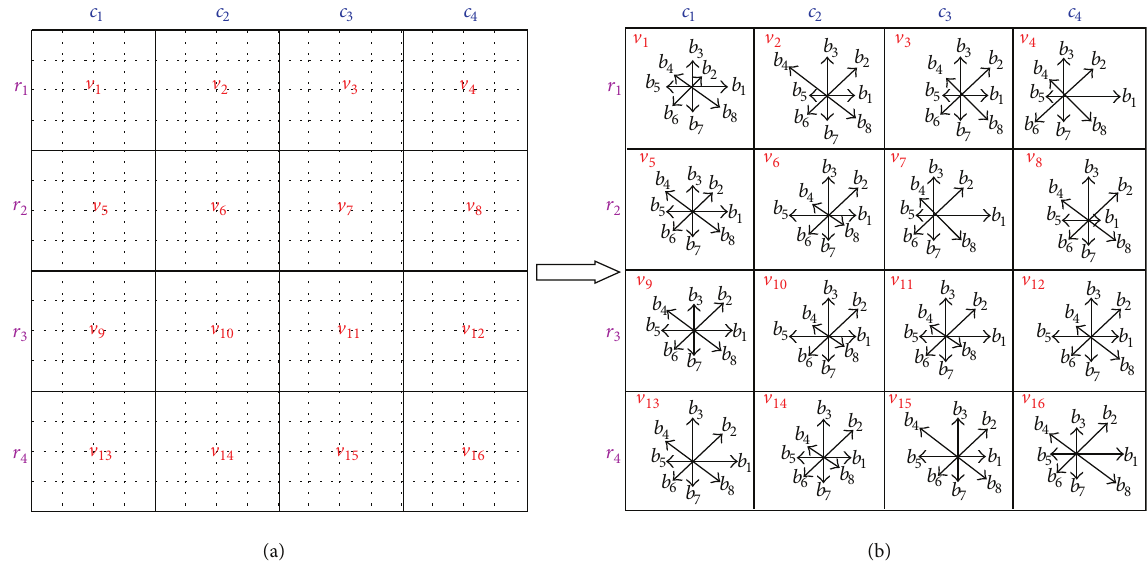
Figure 5: The process of computation of keypoint descriptor. The corresponding gradient magnitude and orientation at each sample point in a region around keypoint location are computed firstly, as shown in (a). Then these samples are accumulated into orientation histograms summarizing the contents over 4 × 4 subregions, with the length of each arrow corresponding to the sum of the gradient magnitudes near that direction within the region, as shown in (b). (a) Image gradients; (b) keypoint descriptor.